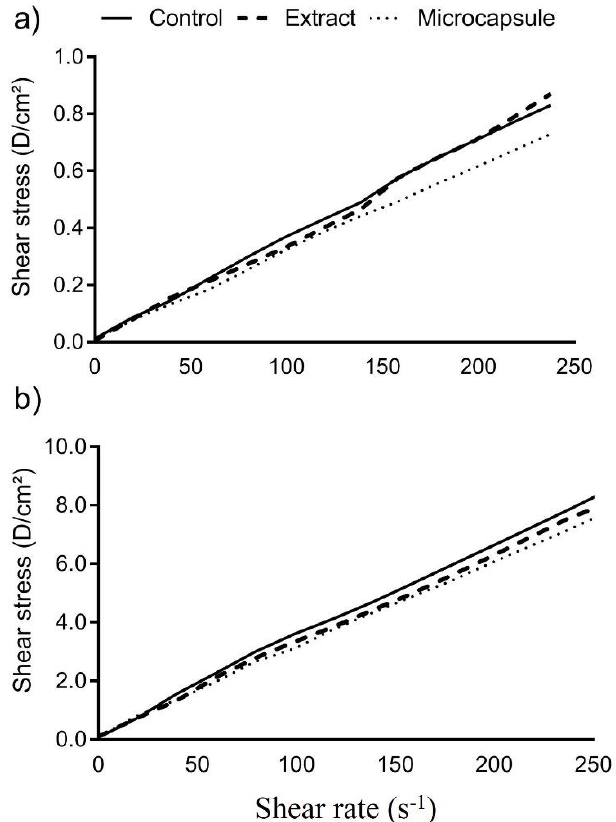
Figure 7. Rheograms of non-dairy beverages with propolis at 4 ◦ C [Non-dairy matrix (N-DM): 1 Control—consists only of the fermented beverage (N-DM); 2 Extract—beverage (N-DM) with propolis extract (DPE); 3 Microcapsule—beverage (N-DM) with microencapsulated propolis (D.M.P.)].